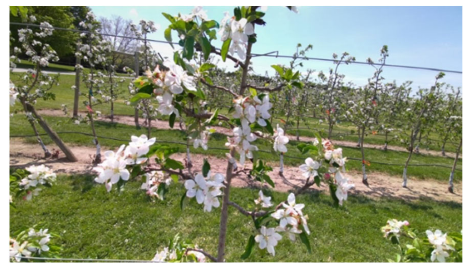
Figure 3. Close ‐ up view of the fruit flowers used in the study.